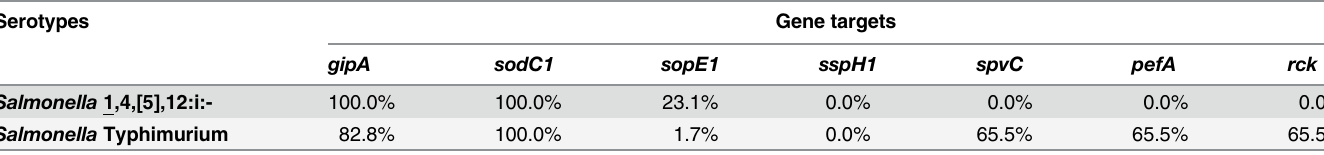
Table 3. Prevalence (%) of the virulence genes by serotype. Serotypes